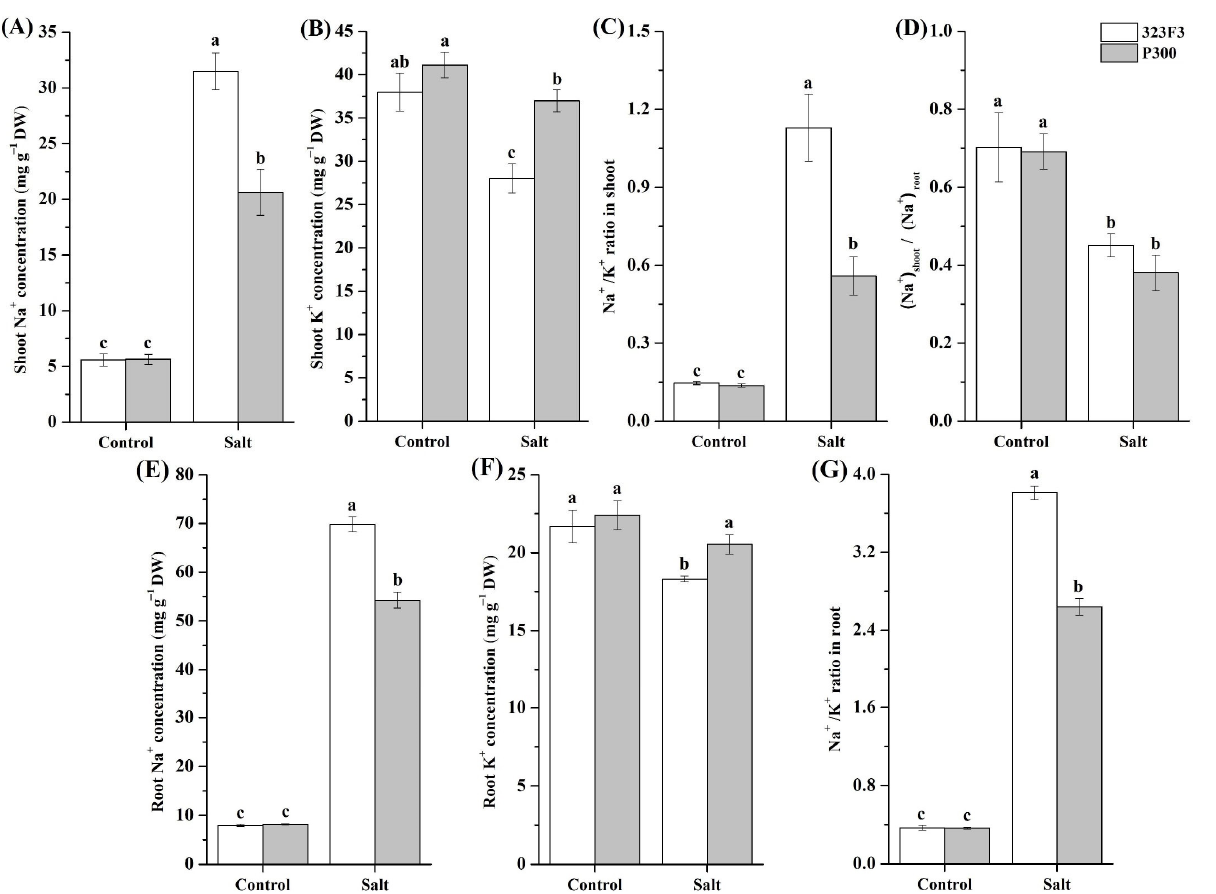
Figure 1. Performance of 323F3 and P300 seedlings in response to salt stress. ( A ) Phenotypes after 20 d salinity stress with 150 mM NaCl. ( B , C ) Salt stress tolerance index of different parameters from the shoot and root, respectively. Each bar represents three biological replicates ± SD. * p < 0.05; ** p < 0.01; NS, not significant (according to one ‐ way ANOVA).